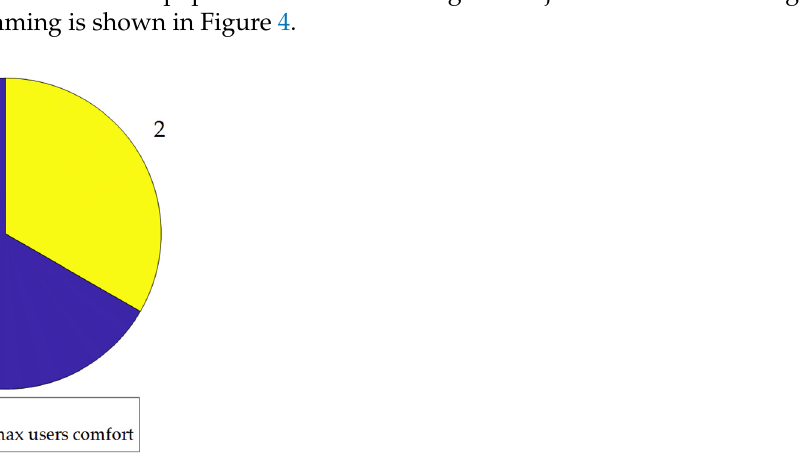
Figure 4. Number of selected papers associated with a given objective for mixed-integer linear programming.